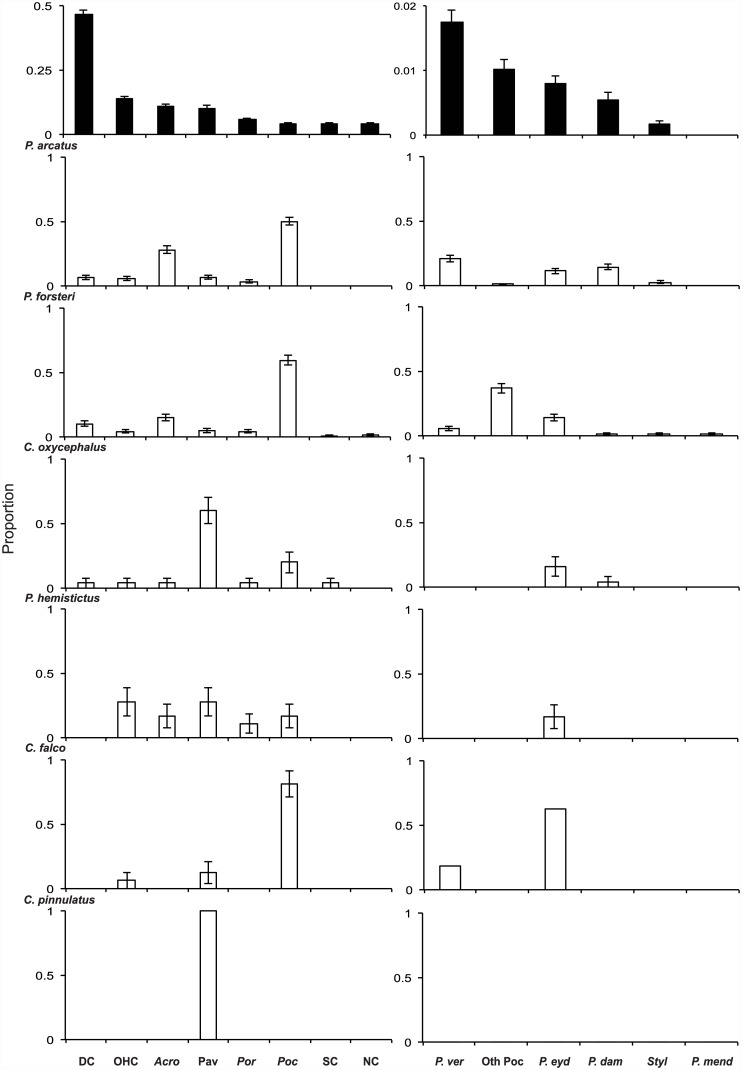
Proportion of available versus used habitat categories for hawkfishes.Proportion of available habitat categories (black bars) across all locations and the proportion of fish that each benthic category was used by each hawkfish species (white bars). Figures on the left display habitat associations for each species across all habitat categories and on the right among different species of Pocilloporidae. Note scale differences for available. Abbreviations: DC = dead coral, OHC = other hard corals, Acro = Acropora, Pav = pavement, Por = Porites, Poc = Pocilloporidae, SC = soft coral, NC = Non-coral, P.ve r = Pocillopora verrucosa, Oth Poc = Other Pocilloporidae, P.eyd = P. eydouxi, P.dam = P. damicornis, Styl = Stylophora, P.mend = P. meandrina.